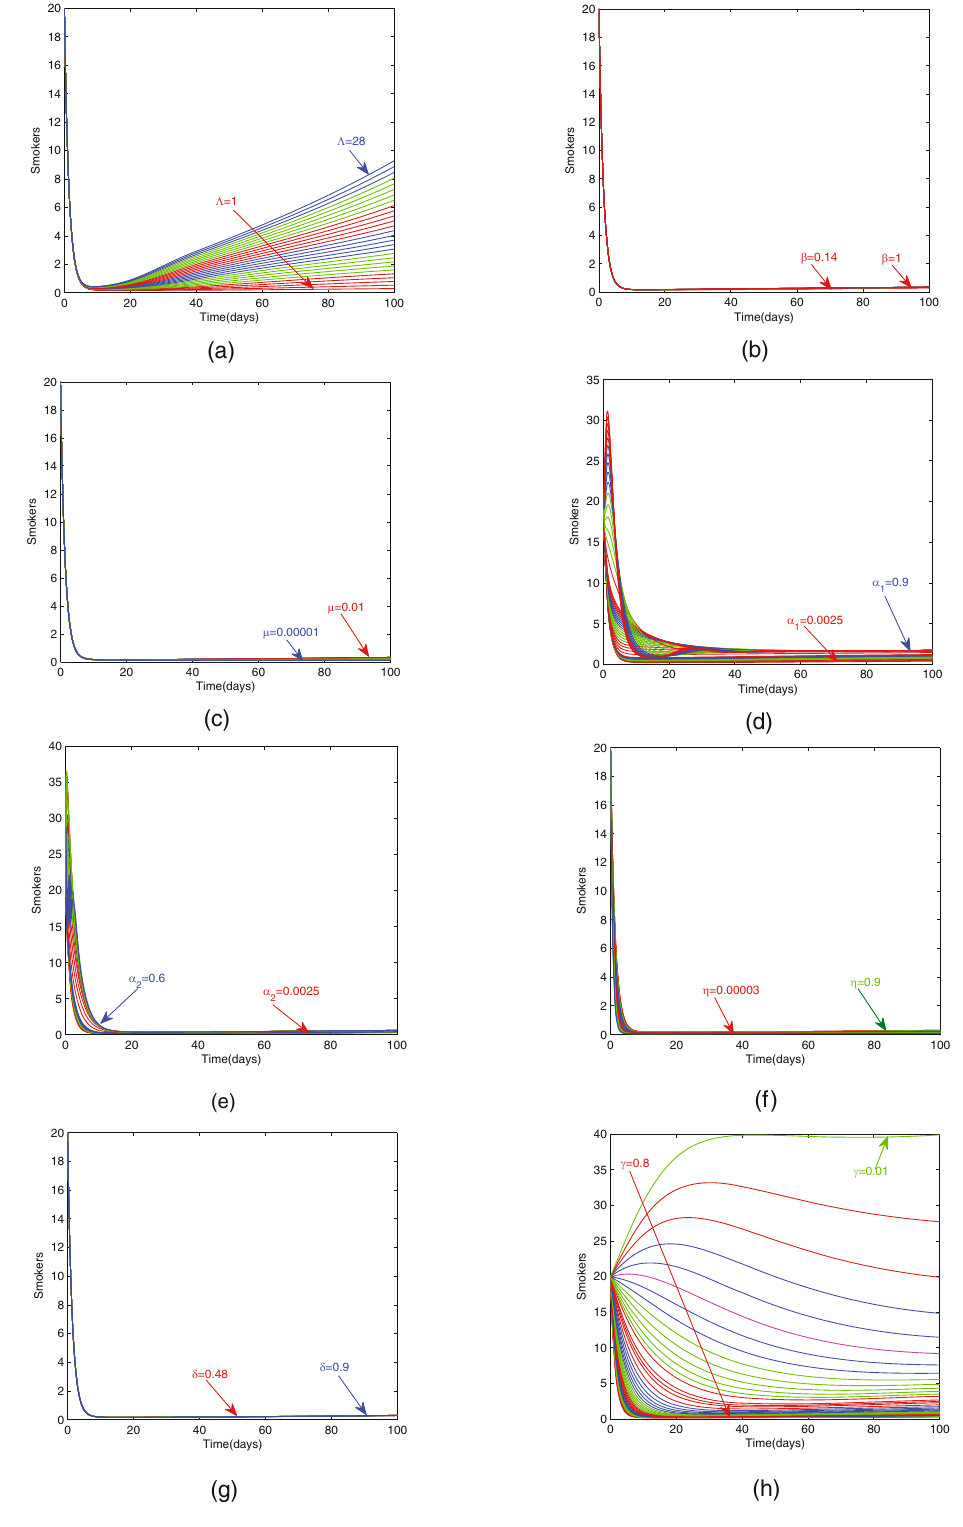
Figure 5: Variation in the endemic level of S ∗ ( from a – h ) with respect to model